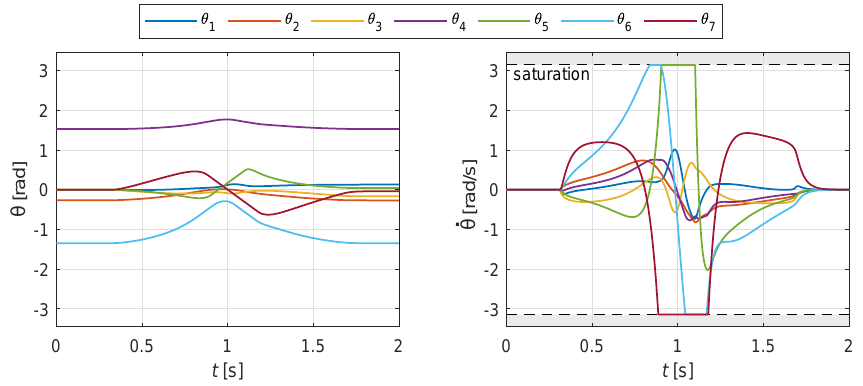
Figure 11. Example 1: joint rotations and speeds for the motion shown in Figure